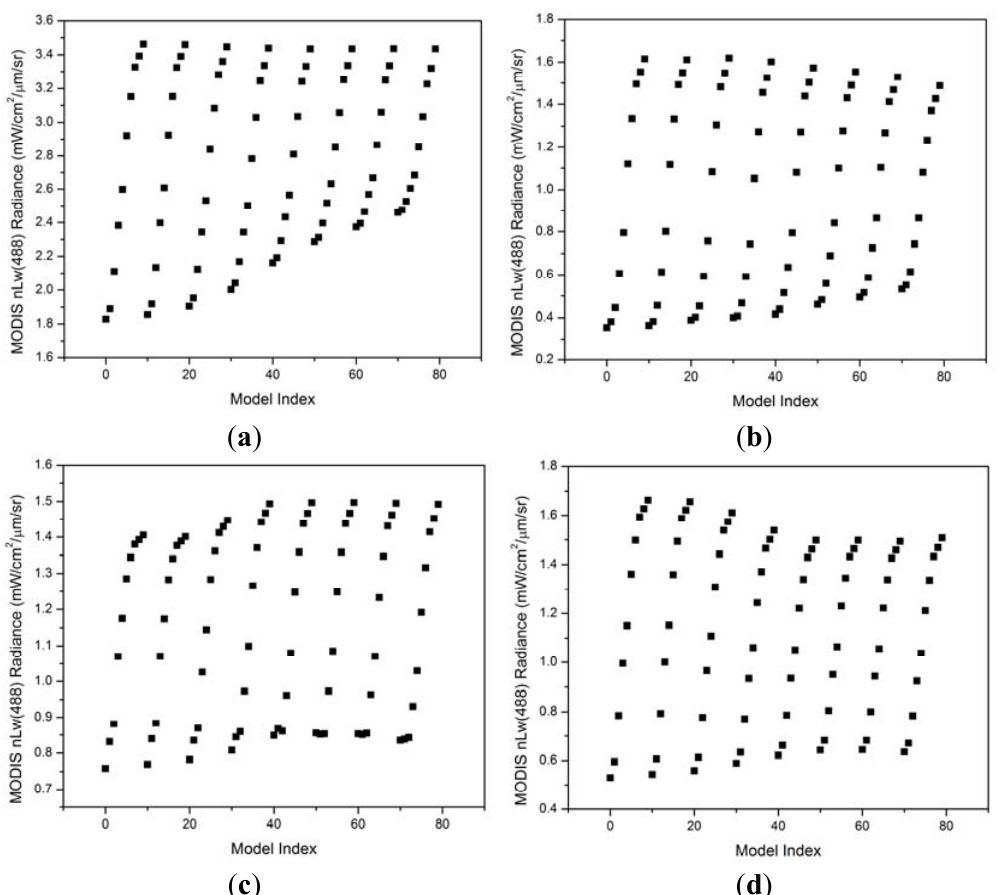
L (488) for 80 aerosol models at the AERONET-OC n w